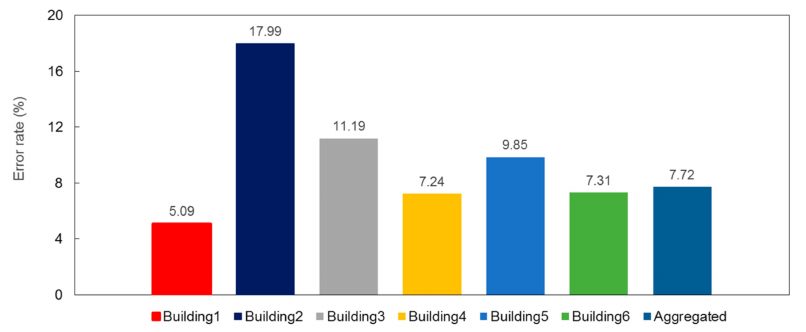
Figure 16. Average percentage error results for autumn